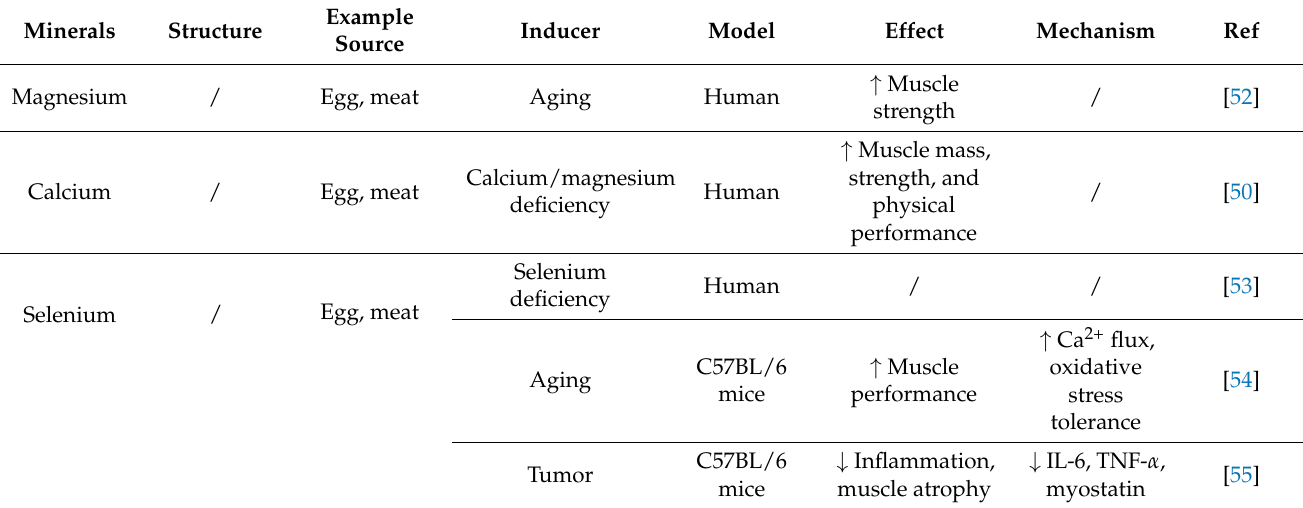
Table 2. Minerals in the prevention of the muscle atrophy in